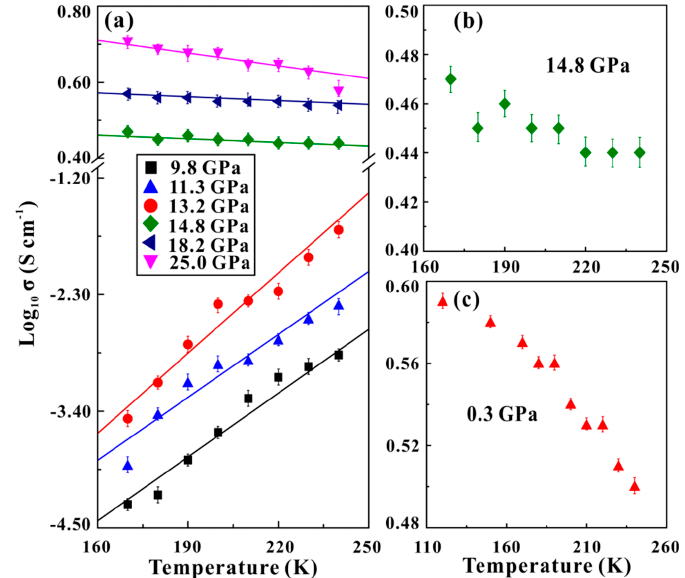
Figure 5. ( a ) The pressure dependence of electrical conductivity for nanocrystalline rutile as a